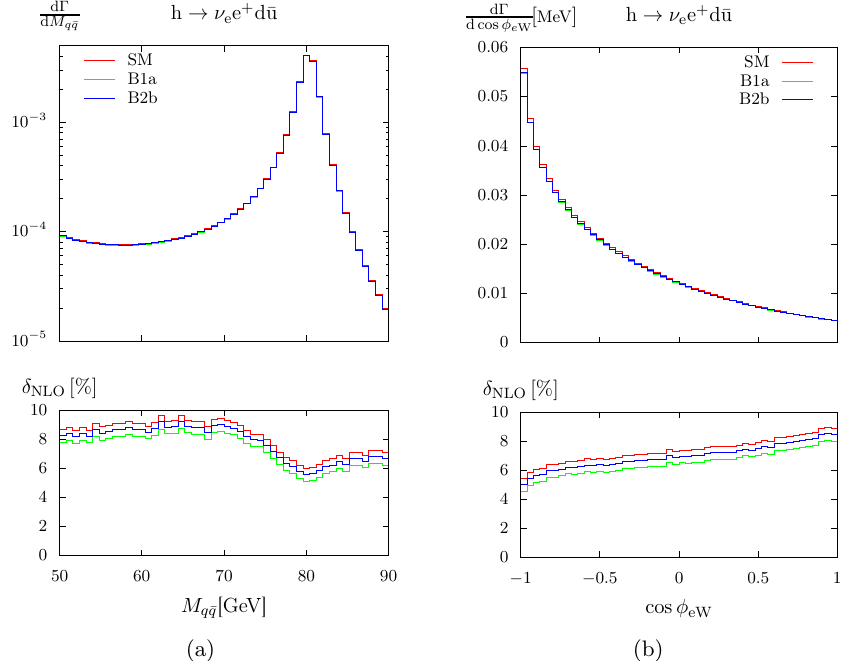
Figure 39 . Invariant-mass (a) and angular distributions (b) of the charged-current semi-leptonic decay h (cid:23) e e + d(cid:22)u for the SM and the THDM scenarios B1a and B2b. The relative NLO corrections ! to the distributions are plotted in the lower panels.